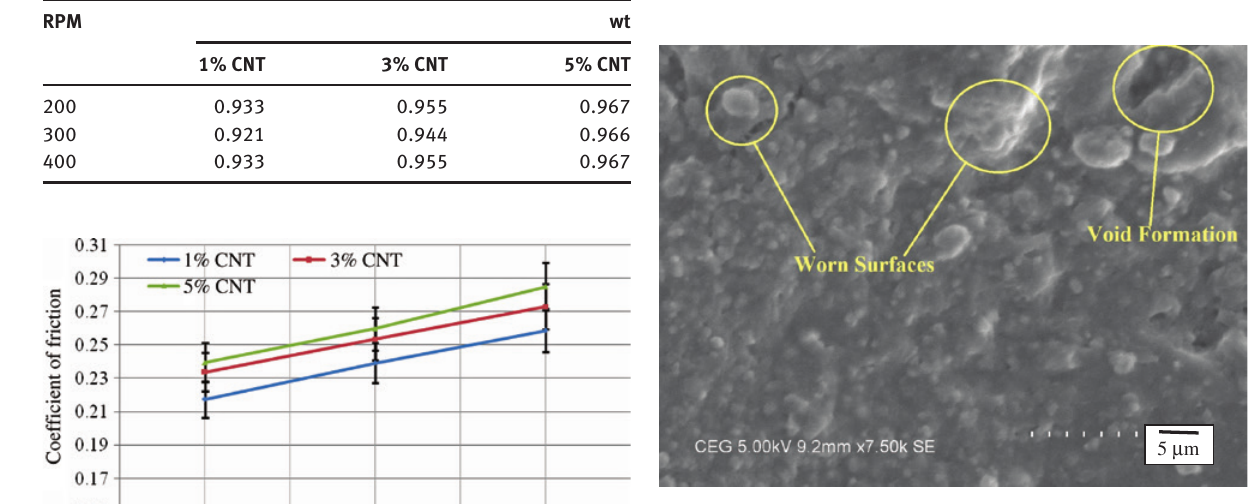
Figure 12: GFRP with CNTs 1% after wear.